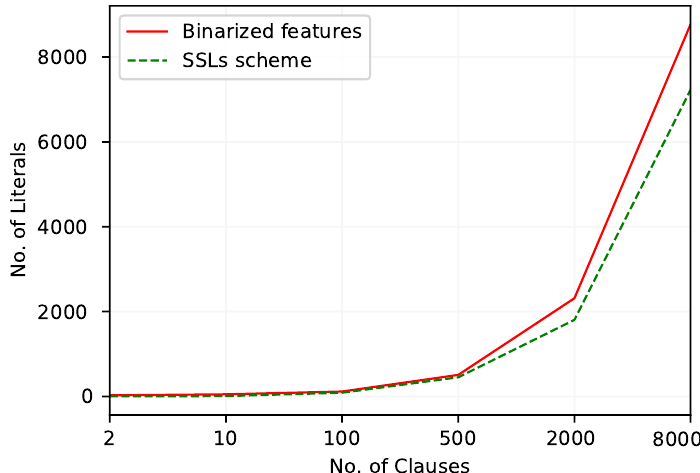
Figure 6. The number of literals included in TM clauses to work with the Liver Disorders dataset.